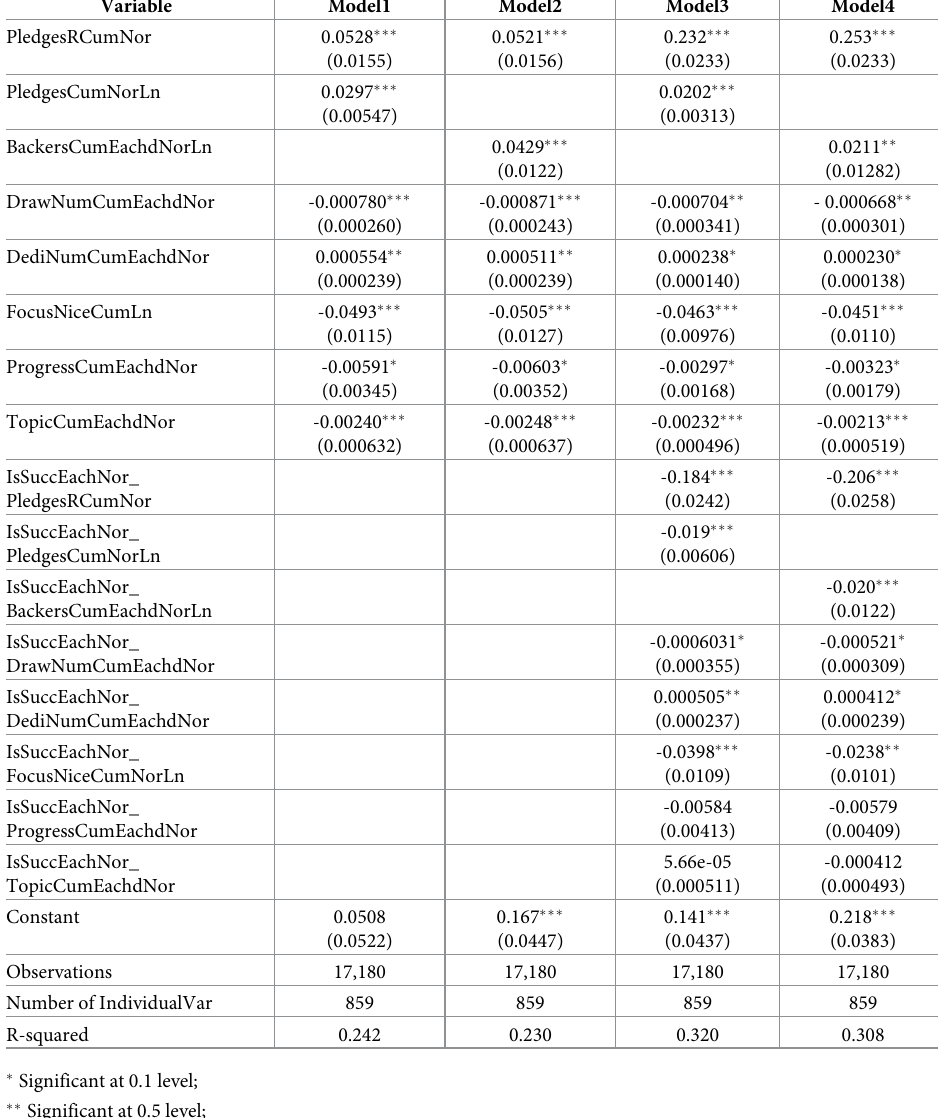
Table 5. Fixed effect on the explicit signals of